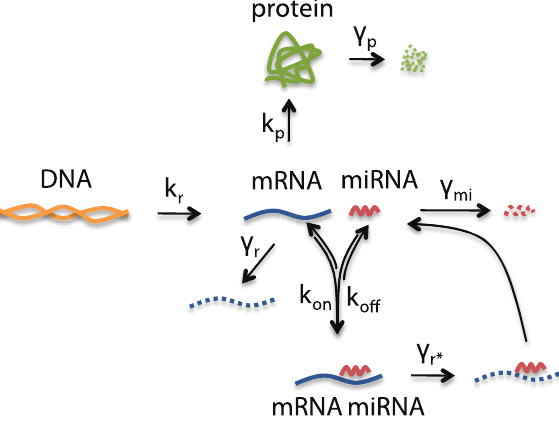
Figure 5. Single gene expression model with post-transcrip- tional self-repression.